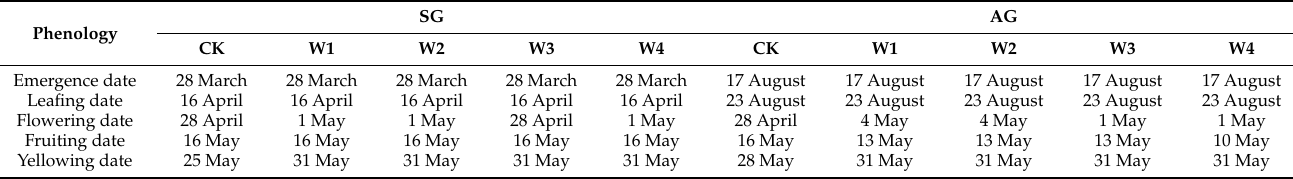
Table 1. Effects of extreme precipitation on phenology of SG and AG plants of Erodium oxyrhynchum . Phenology